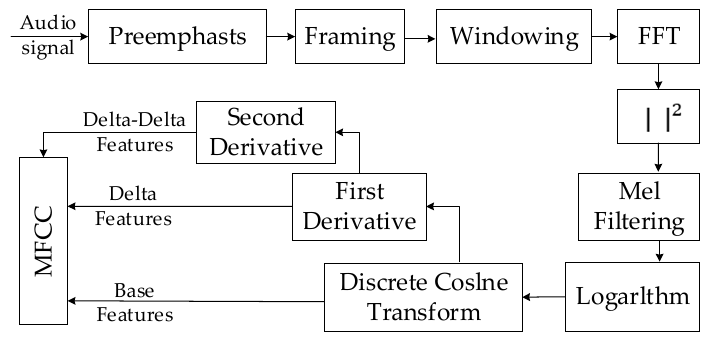
Figure 3. The process of feature extraction.